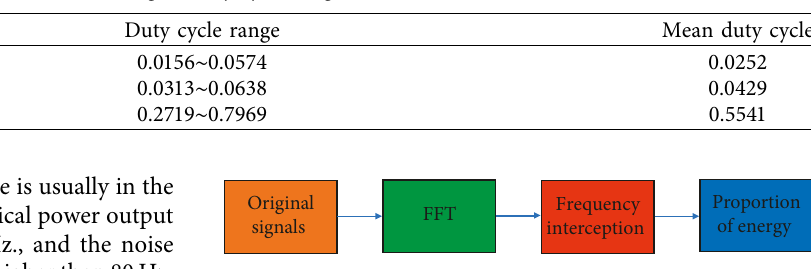
Figure 4: Frequency domain feature extraction.